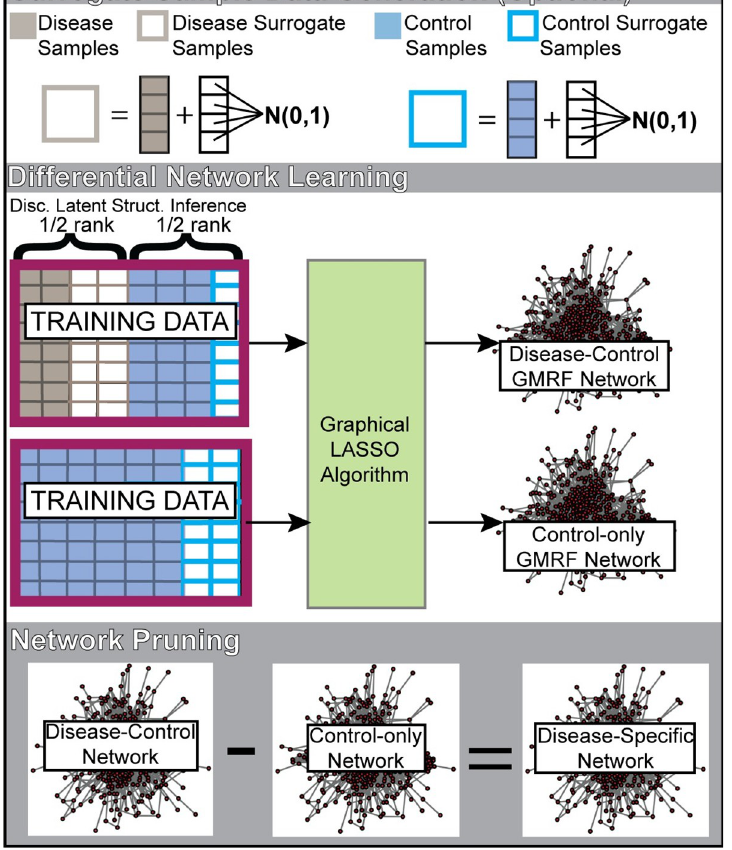
Fig 8. Construction of disease-specific co-perturbation networks. Two networks are learned using a Gaussian Markov Random Field network learner. The first network (“disease-control” network) is learned from disease profiles, disease surrogate profiles, control profiles, and surrogate control profiles. Importantly, half the matrix rank is composed of disease and/or disease surrogate profiles and the second half of the matrix ranks is composed of control and/or surrogate control profiles. A second network composed of only control and surrogate controls is also learned (“control-only” network). A final pruning stage subtracts edges from the disease-control network that are also found in the control-only network, outputting the disease-specific network. Disc. Latent Struct. Inference–Discriminative latent structure inference; GMRF–Gaussian Markov Random Field; N(0,1)–the standard normal